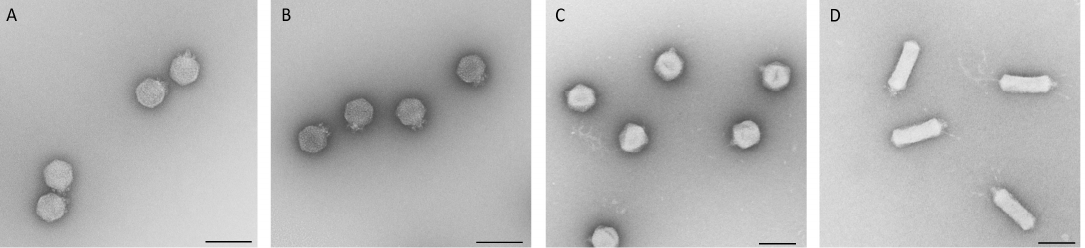
Figure 3. Electron micrographs of isolated phages KAW1A4500 ( A ), R4596 ( B ), PTXU04 ( C ), and WFI101126 ( D ) of the podoviruses. Negative staining (2% ( w / v ) uranyl acetate, pH 5.0). Bars represent 100